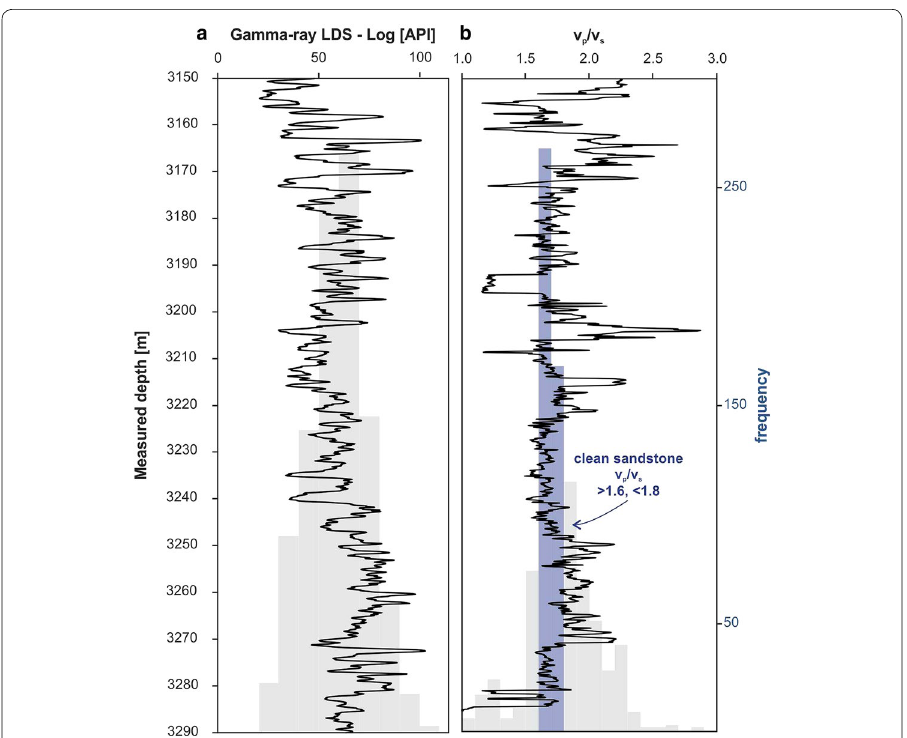
Fig. 10 Vertical bore logs of lithological and mineralogical properties and the corresponding histograms. a Results from LDS gamma‑ray log, implying reduced API values in the middle of the reservoir. b Ratio of ν s and ν p wave velocities, used to determine the purity of the reservoir sandstone. Typical values for sandstone are marked in